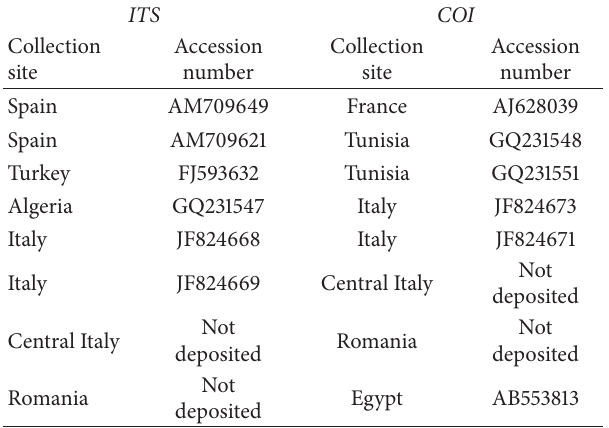
Table1: ITS and COI sequencesof Fasciolahepatica usedtoperform the multiple sequence